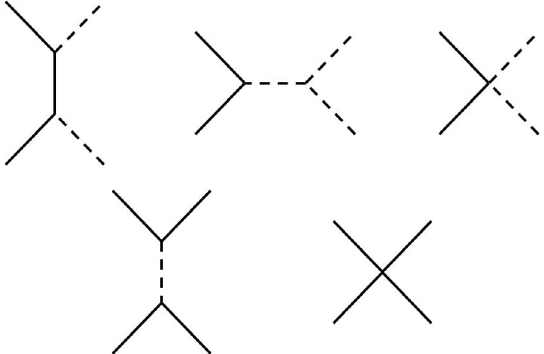
Figure 1 . Tree-level 2-to-2 scattering processes considered for placing an upper bound on Loryon masses from perturbative unitarity: (upper) Loryon pair scattering to a Higgs pair, and (lower) Loryon pair scattering to a Loryon pair. Dashed lines denote physical Higgs boson h and solid lines are for Loryons. Crossed channels are not explicitly drawn. The last diagram in each row is only available for scalar Loryons assuming renormalizable interactions. For each process, the t -channel exchange diagram dominates the